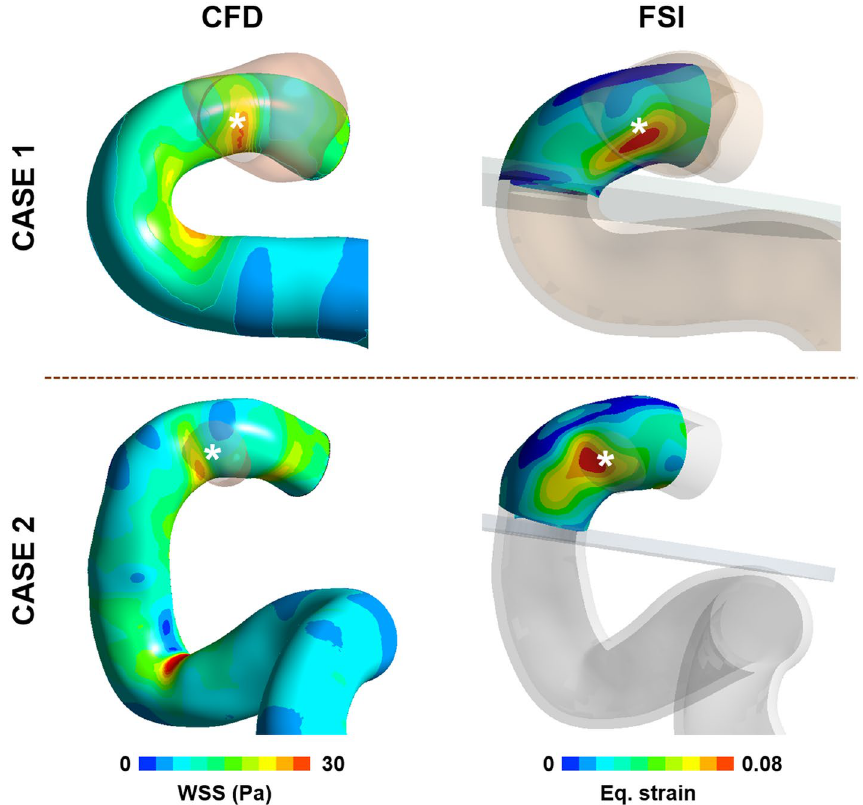
Figure 3. Examples which have high correlation between the location of the aneurysm formation site and the locations of the high WSS and high strain. The results of WSS calculated from CFD and strain calculated from FSI analysis were extracted at the systolic time for comparison of the location of high WSS and strain. A white star (*) indicates the location of aneurysm formation